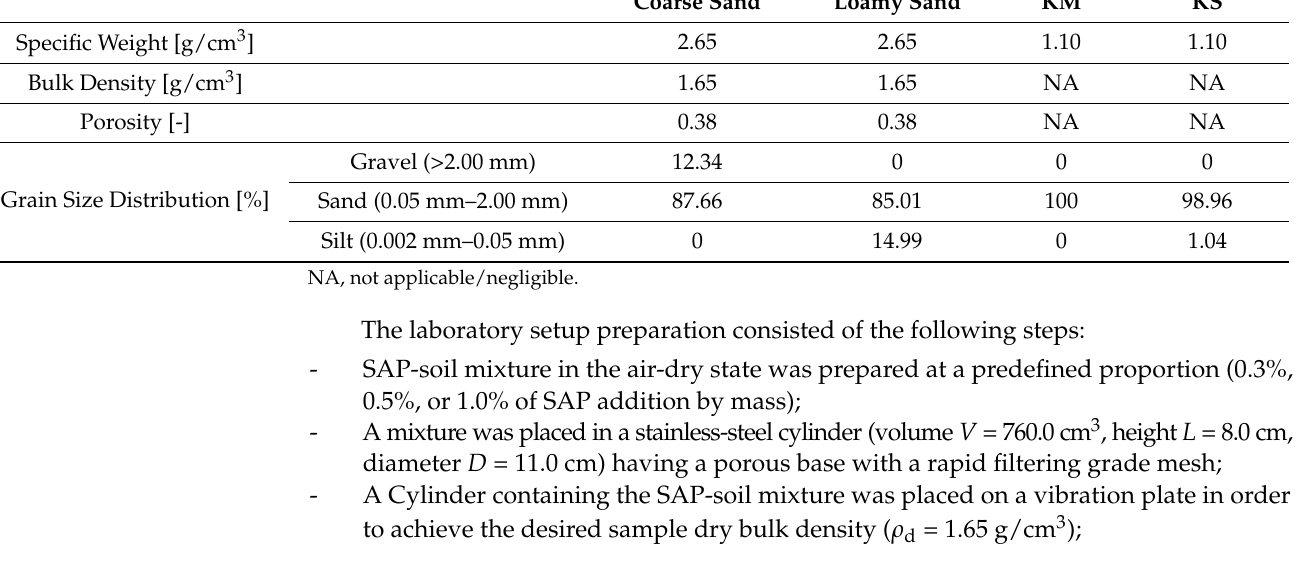
Table 1. Basic properties of the soils and SAPs used for study.